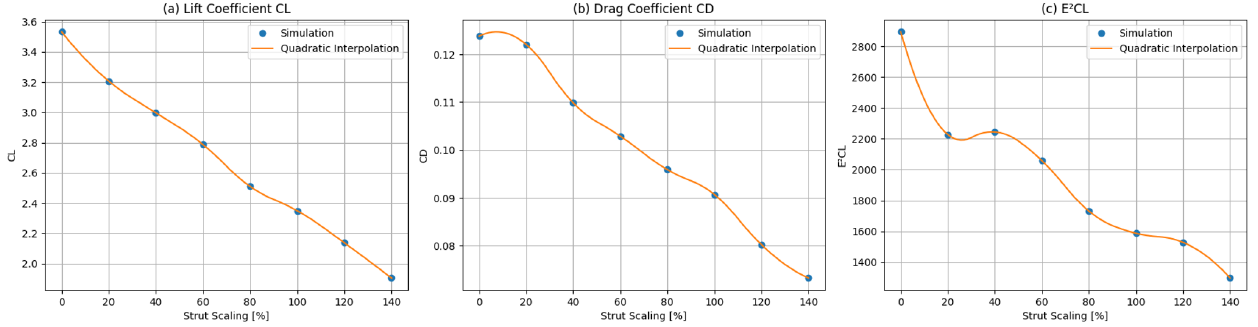
Figure 14. Effect of relative strut scale on (a) C L , (b) C D and (c) E 2 C L .